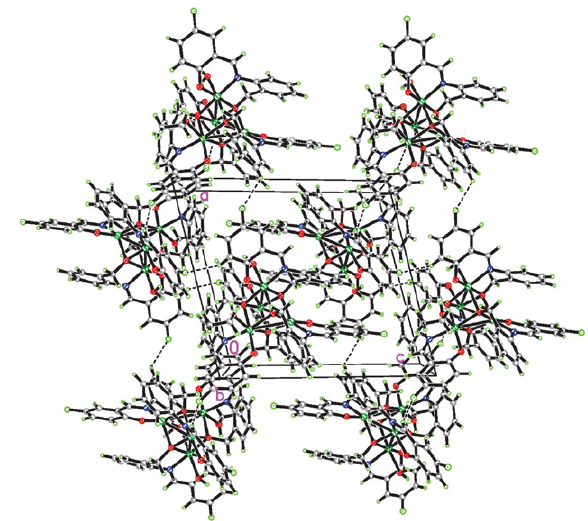
Fig. 4. Hydrogen bond (dashed lines) linked 3D network of com- plex 2 , viewed along the b axis.